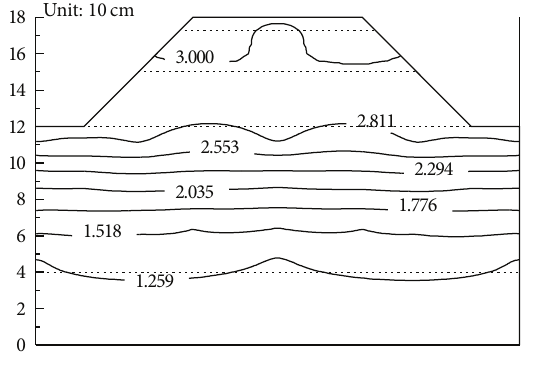
Figure 9: At 0.252 g loading acceleration.